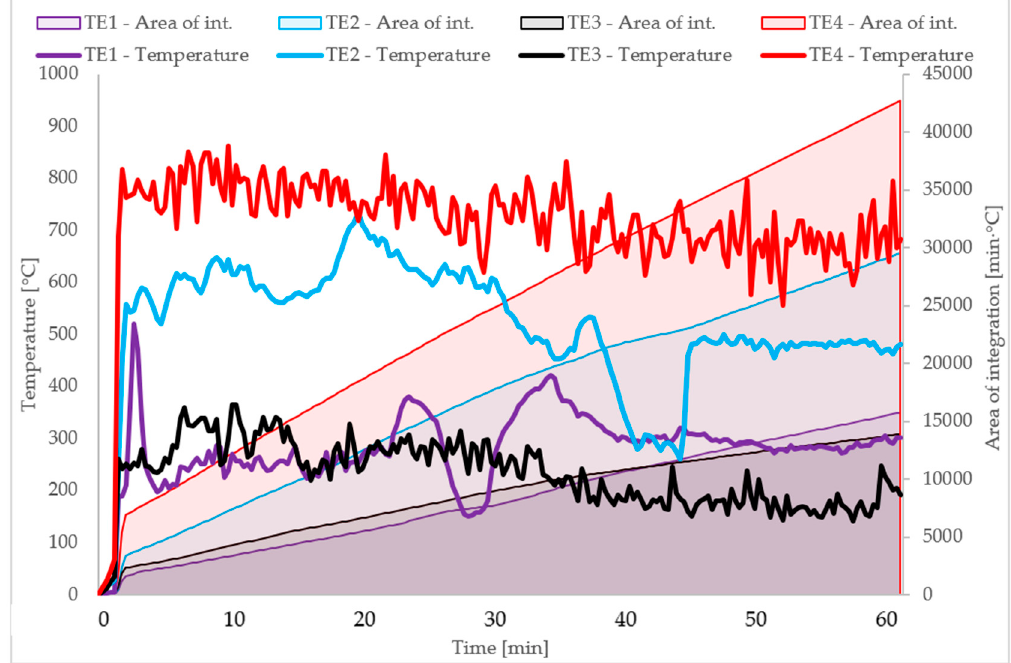
Figure 8. Temperature measurement results for thermocouples and the increasing integral for the temperature-time function. Table 2. Aggregate summary of averaged values of fracture energy W f and modulus of rupture MOR for panels, under the influence of high temperature 400 °C from 1 to 15 min [1].